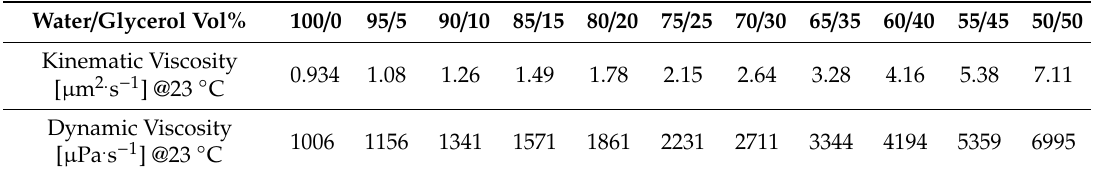
Table 1. Kinematic and dynamic viscosities of di ff erent water–glycerol mixtures calculated analytically using Equations